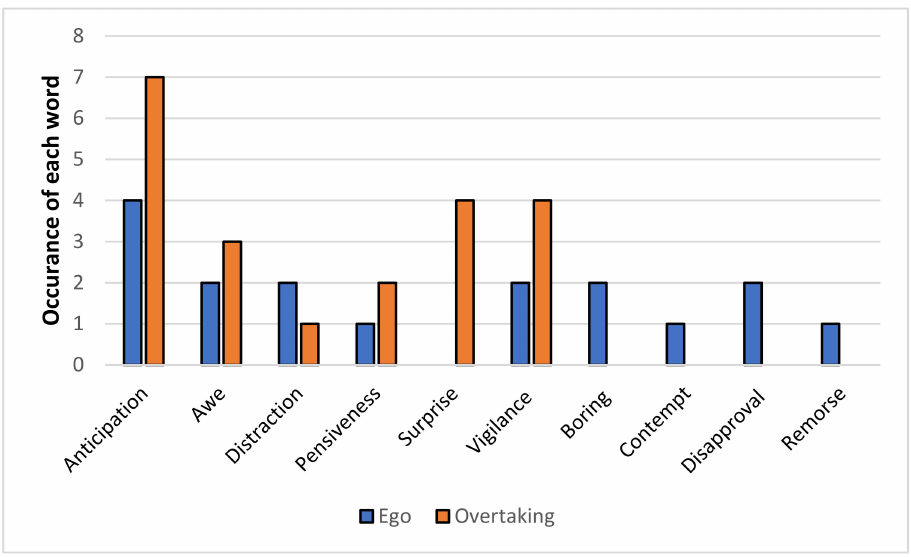
Figure 12. Occurrence of negative